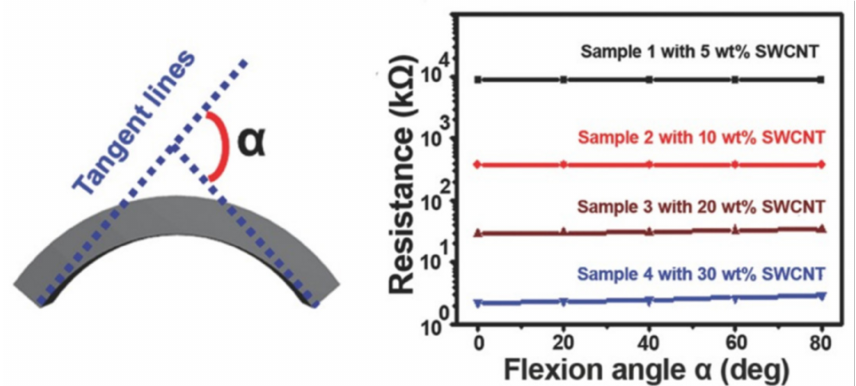
Figure 4. The definition of flexion angle α and the resistance change upon increasing α [25]. Repro- duced with